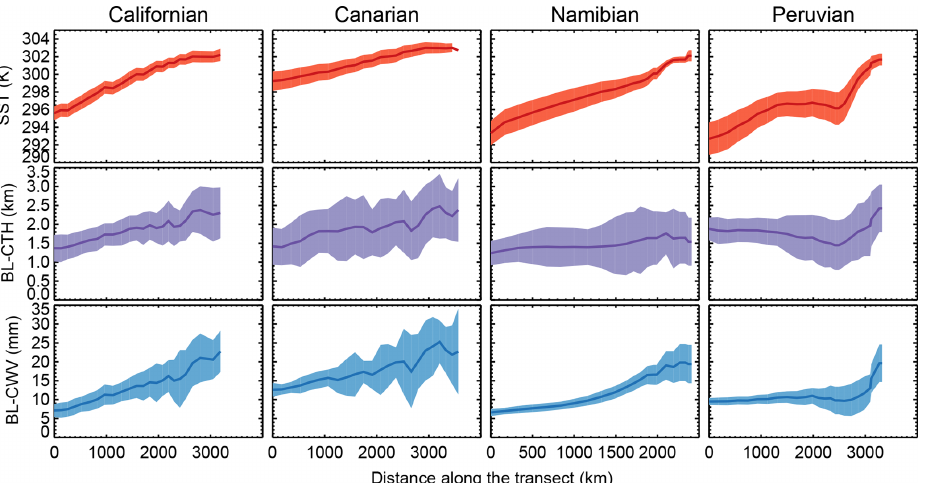
Figure 12. Climatological SST, BL-CTH, and BL-CWV along the transects shown in Fig. 11. The envelopes display the standard